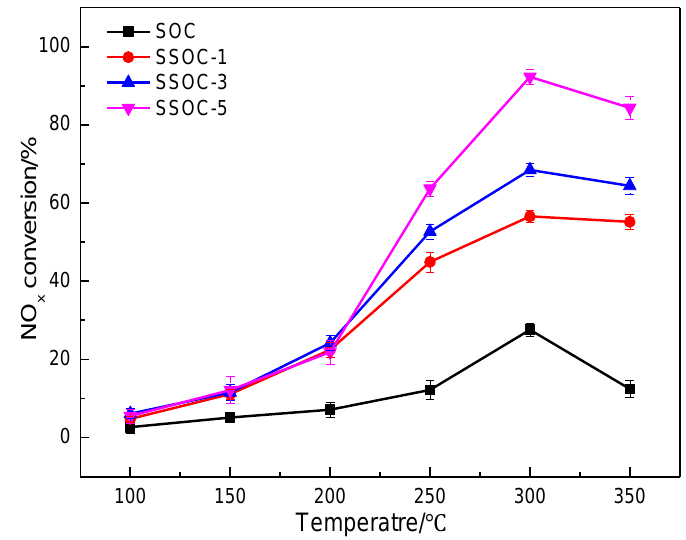
Figure 4. DRIFT spectra of SOC( a ) and SSOC( b ) exposed to 1000 ppm NH 3 at 300 ˚ C at different time.